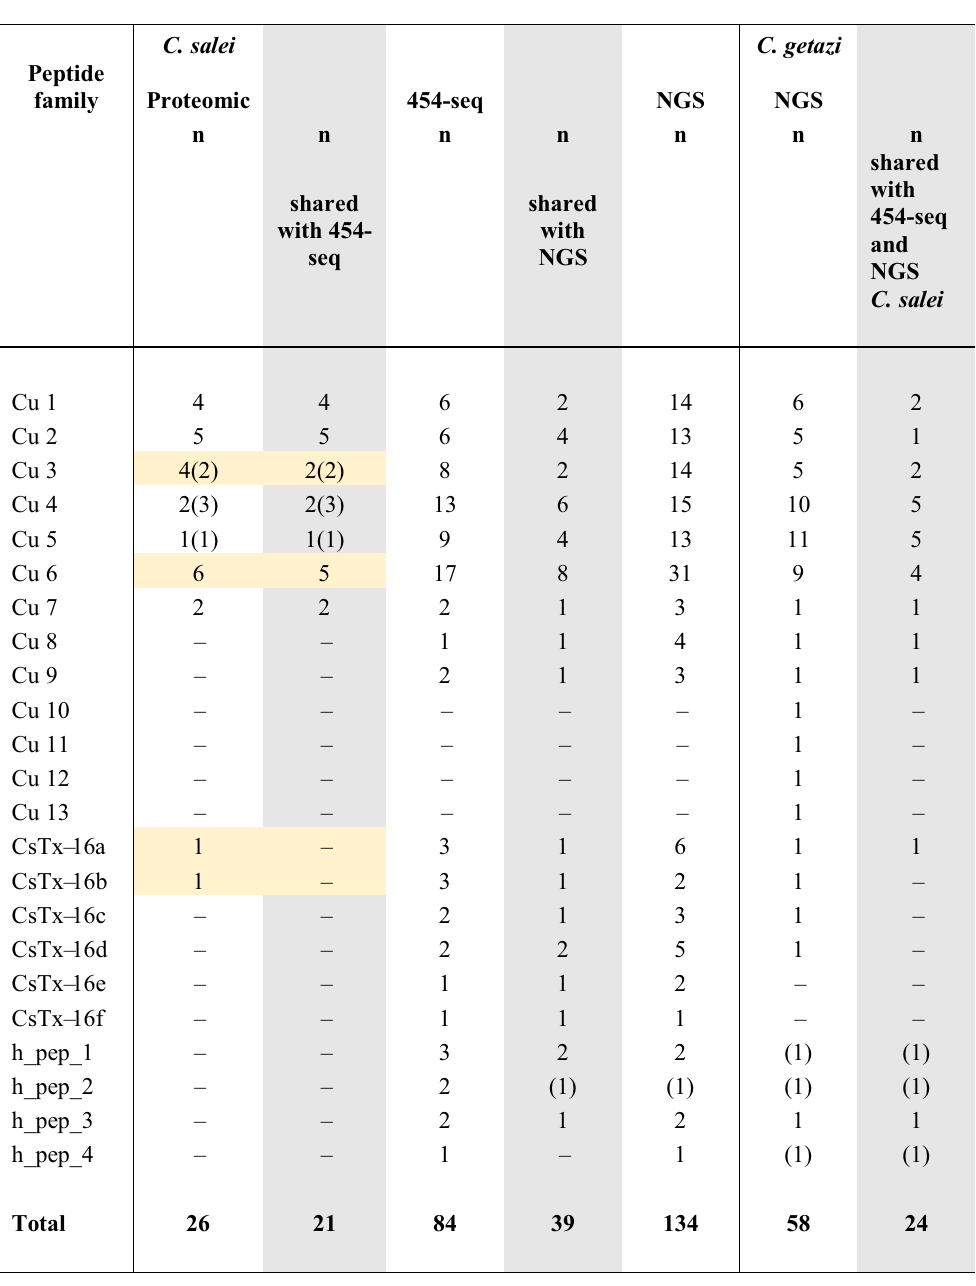
Table 2. Overview on identified LPs of C. salei by 454-sequencing and NGS as well as of C. getazi by NGS sequencing. Additional numbers in brackets refer to truncated variants identified by proteomics, not added to the total number. Here single chains of CsTx-16 are given. Highlighted in orange are LPs identified only in proteomics and highlighted in grey are shared